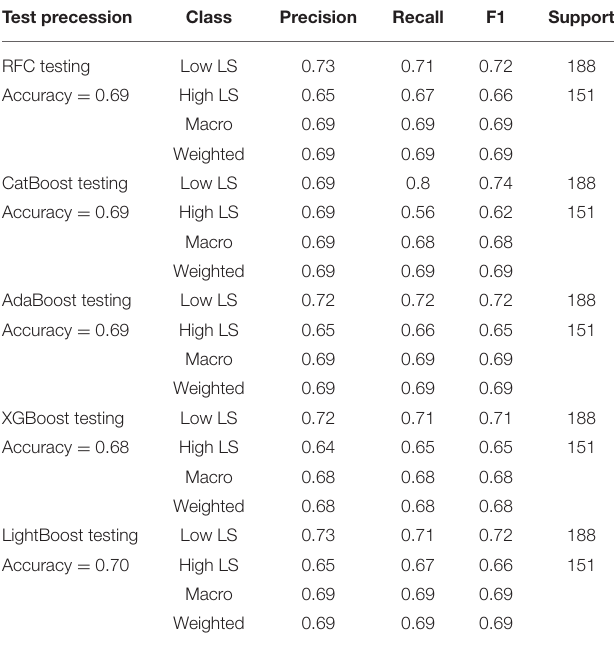
TABLE 2 | Precision, recall, and F1 in testing procession in tree-based model.